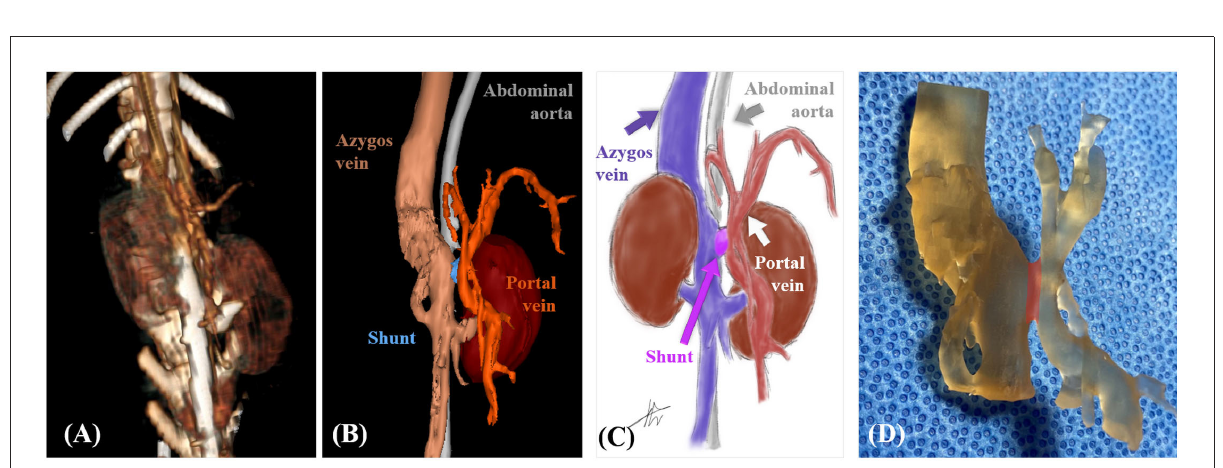
FIGURE6 Case 2. Volume-rendered three-dimensional (3D) projection of the computed tomography (CT) angiography study (A) . Surface-rendered 3D projection of the CT angiography study (B) . Illustrations of vascular anomaly (C) . 3D printed vascular model (areas marked in transparent red color indicate shunt) (D)